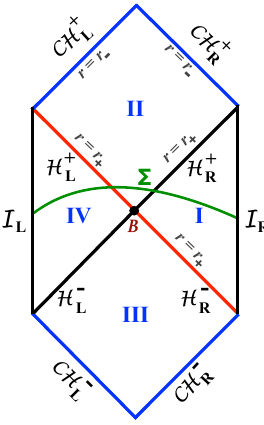
Figure 1 . Penrose diagram for the non-extremal BTZ black hole. Region I is the black hole exterior and region II the interior. The asymptotic timelike boundary is I R , the future event horizon is H + and the past event horizon is at H (cid:0) . Region III is the white hole region. Region IV is another R asymptotically AdS region with timelike boundary I L and future event horizon H + \left" and \right" future Cauchy horizons,